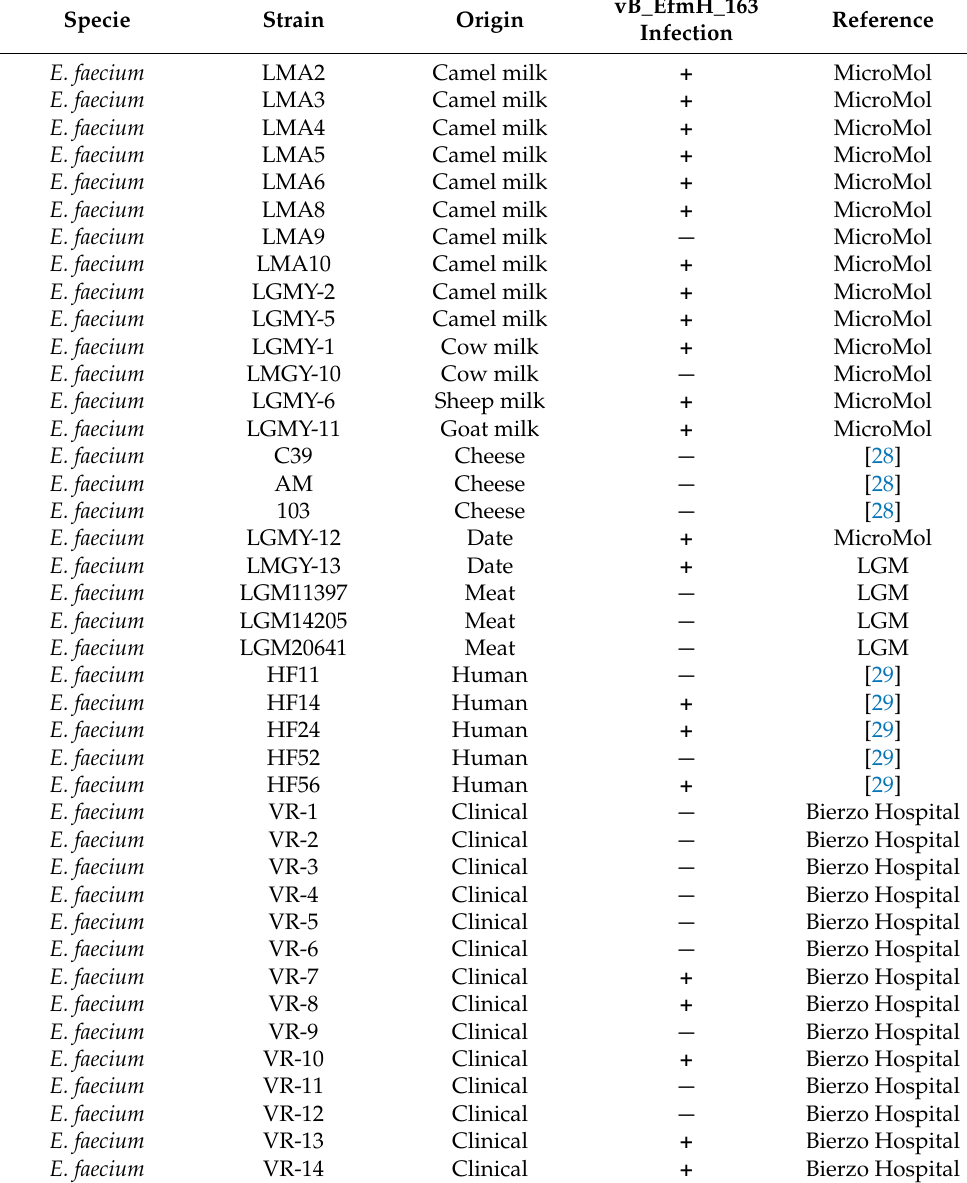
Table 1. E. faecium and E. faecalis strains used in this work for bacteriophage vB_EfmH_163 isolation and host range